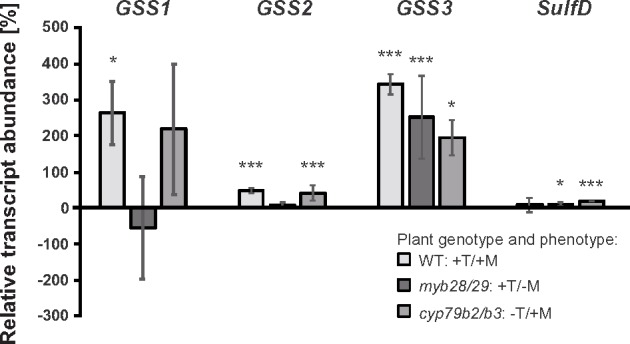
GS-dependent transcription of arylsulfatase genes from Plutella xylostella. DBM-C larvae fed on four Arabidopsis genotypes with distinct GS phenotypes. Arabidopsis wildtype (WT) has both Trp- and Met-derived GS (+T/+M), whereas myb28/29, cyp79b2/b3, and cyp79b2/b3/myb28/29 mutants are defective in Met-GS (+T/−M), Trp-GS (−T/+M), and Met- and Trp-derived GS (null mutant), respectively. Shown are relative differences in arylsulfatase transcript abundance (±SEM of three biological replicates) in comparison to the GS null mutant (*P ≤ 0.05 and ***P ≤ 0.001), according to post hoc two-tailed t-tests.